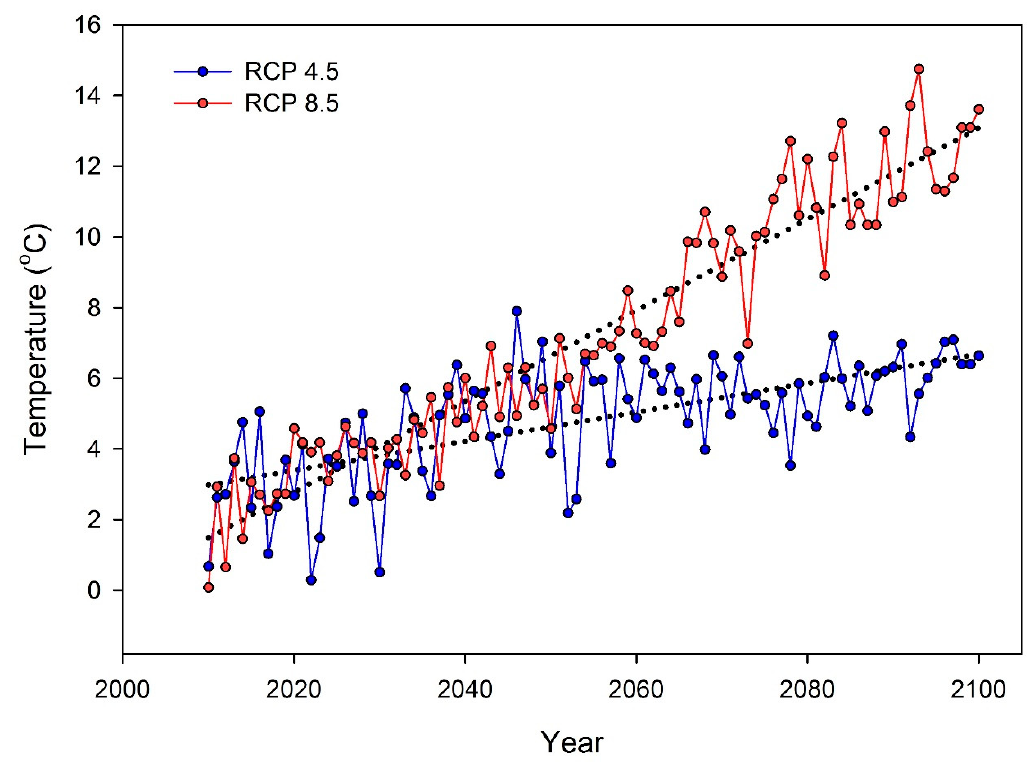
Figure 9. The trend of yearly projected average temperature (°C) under representative concentration pathways (RCP) 4.5 and RCP8.5 climate change scenarios for the Astore